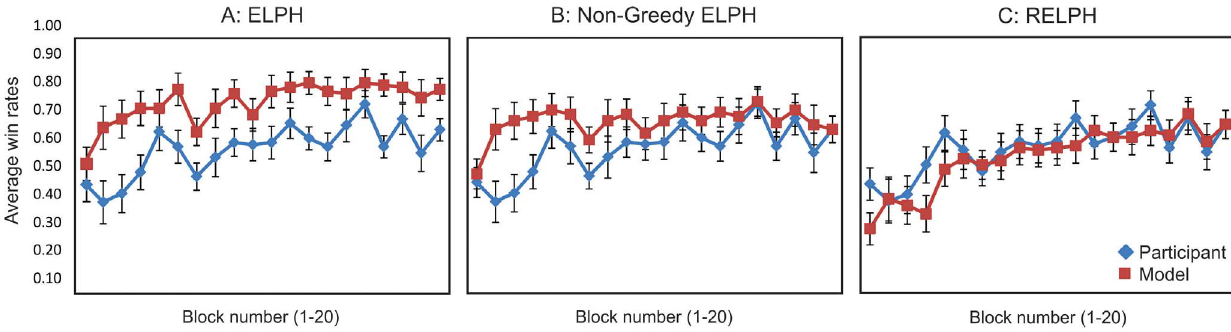
Figure 1. The average win rate of HCs versus ELPH and RELPH. Each plot shows the average win rate over the last 200 trials in the RPS experiment of Danckert et al. [13] for HCs versus (A) ELPH, (B) non-greedy ELPH and (C) RELPH. The blue line represents the average win rate of HCs. The red line shows the average win rate for the (A) ELPH, (B) non-greedy ELPH and (C) RELPH. Error bars represent the standard error of the mean.